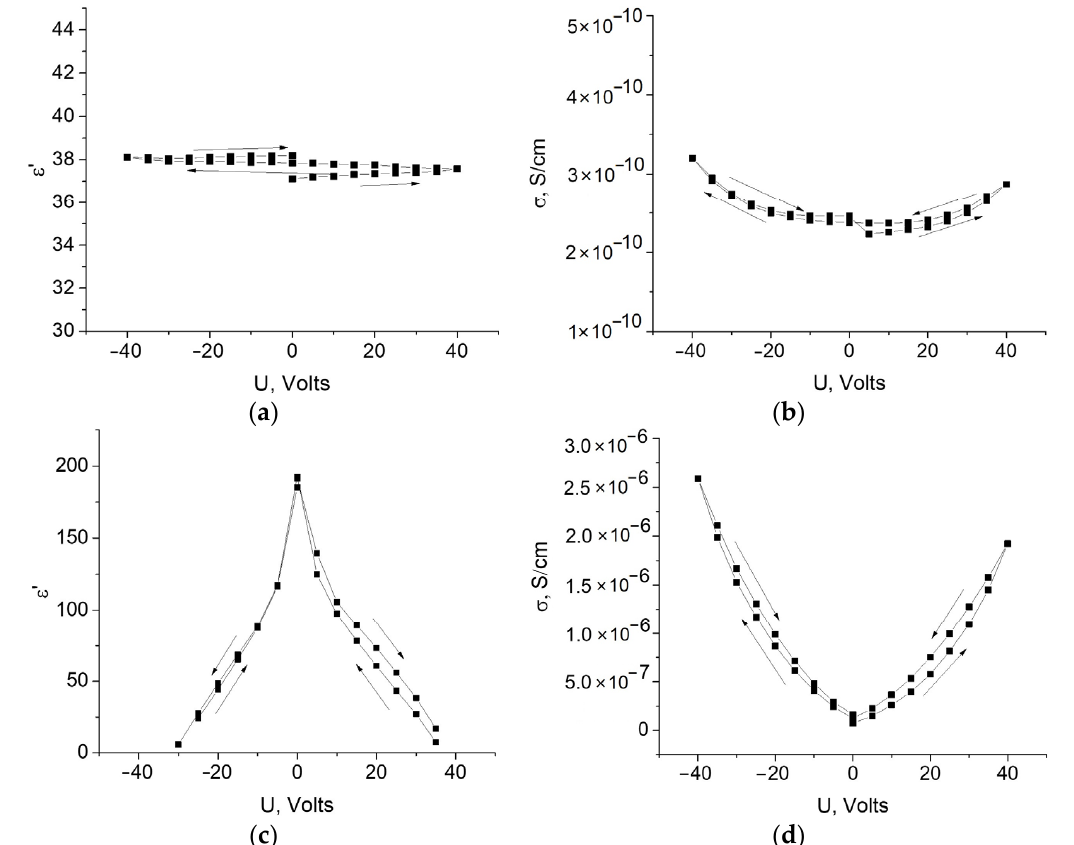
Figure 5. Dielectric constant ( a , c ) and conductivity ( b , d ) versus DC bias voltage for MAE–Fe ( a,b ) and MAE–Fe–m ( c,d ). f = 100Hz.